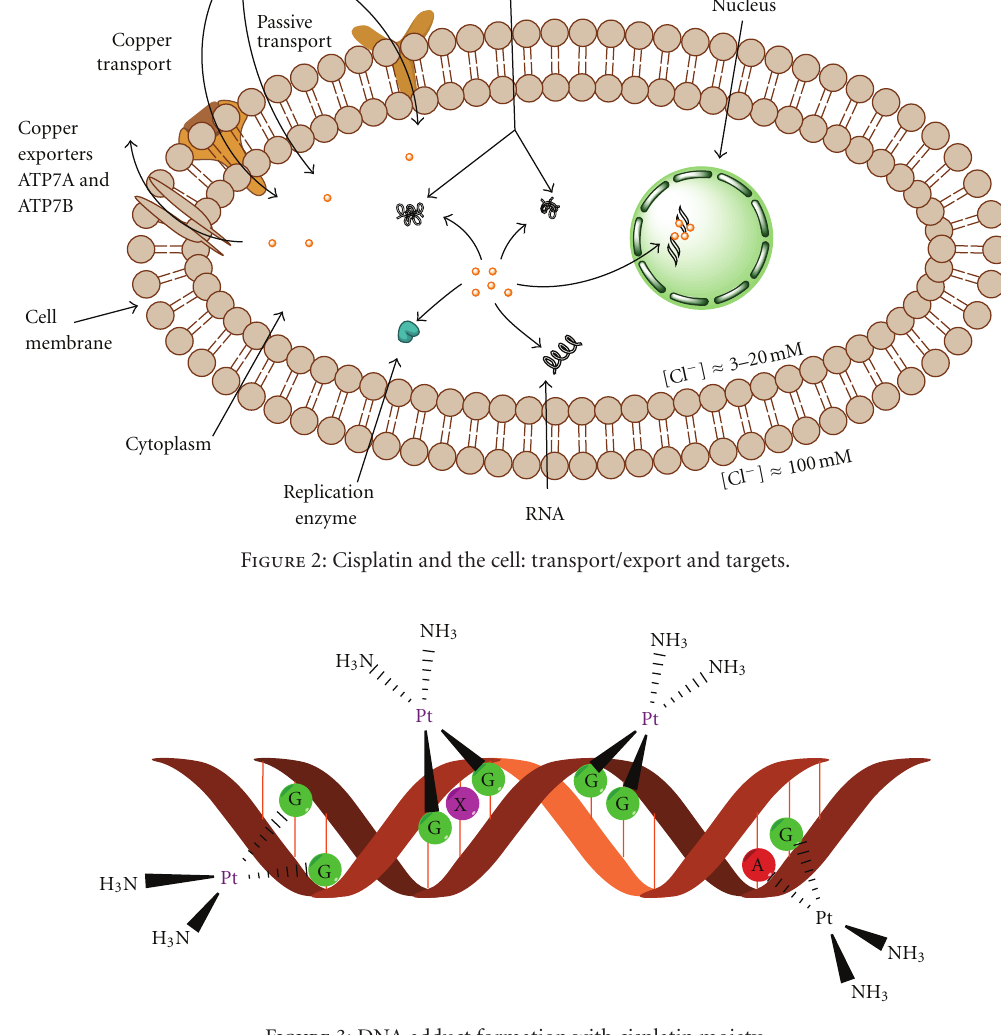
Figure 3: DNA adduct formation with cisplatin